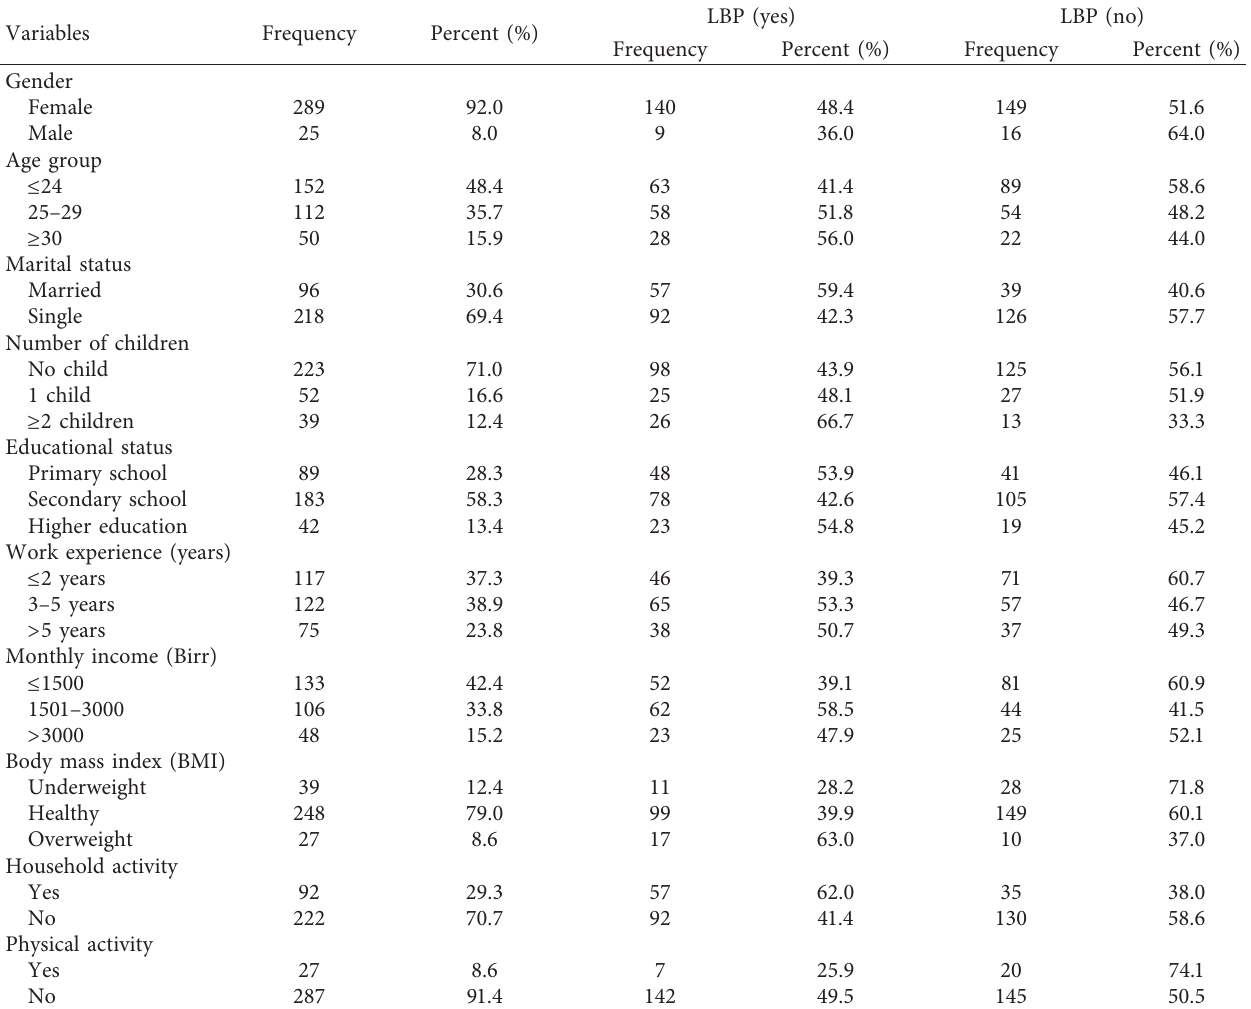
Table 1: Sociodemographic and individual characteristics associated with LBP among the study participants, April 2018 ( n � 314).